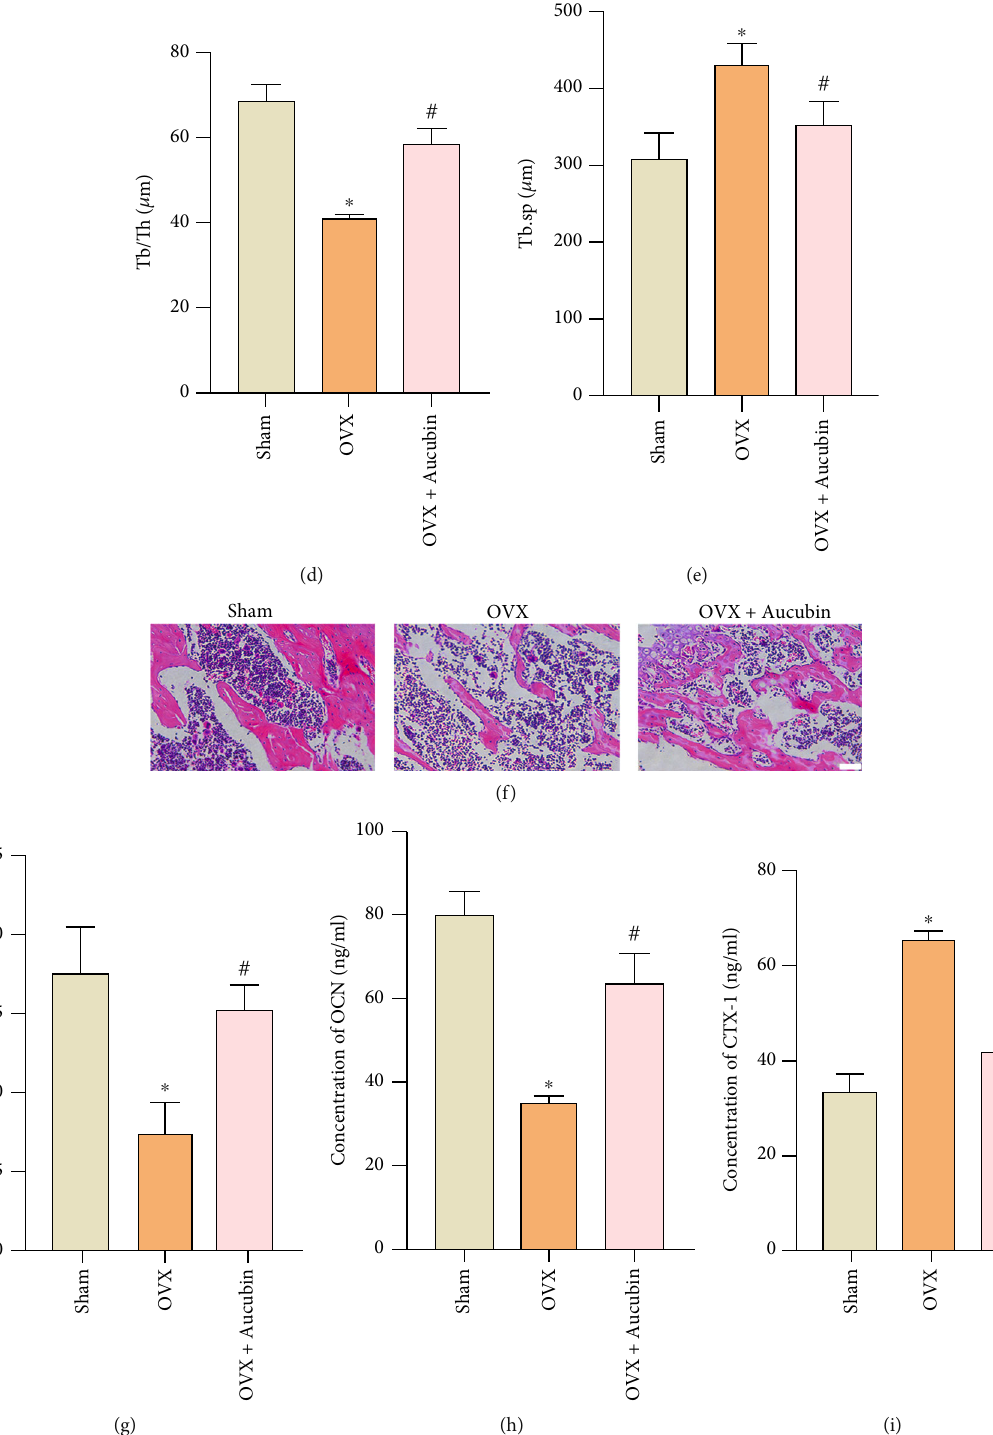
Figure 1: Aucubin ameliorated bone loss induced by OVX. (a) Micro-CT images and quantitative analysis. (b – e) of the mouse femurs from di ff erent groups. BV/TV: bone volume/total volume; Tb.N: trabecular number; Tb.Sp: trabecular separation; Tb.Th: trabecular thickness. (f) Representative haematoxylin and eosin (HE) staining of femurs; scale bar: 100 μ m. (g) Quanti fi cation of BV/TV% of HE staining. (h, i) The concentrations of OCN and CTX-1 in the serum were detected by ELISA. n = 5 per group. ∗ P < 0 : 05 compared to the sham group. # P < 0 : 05 compared to the OVX